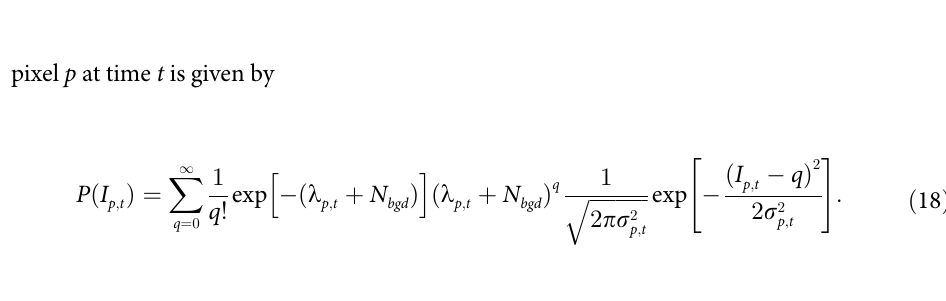
Fig 13. Typical frames related to sCMOS camera model. (a) Observation with N bgd = 10, G = 100. (b) Variance and (c) gain maps of the pixels in the frame shown in (a).